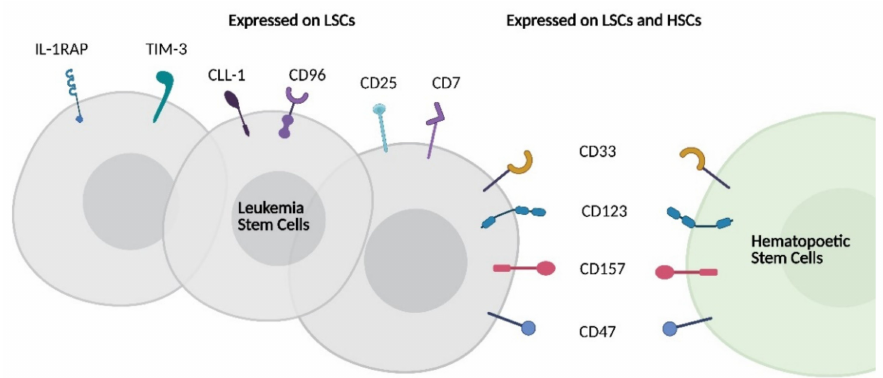
Figure 1. Schematic representing LSC antigen heterogeneity and overlapping expression of thera- peutically relevant LSC antigens with HSCs. LSC = leukemia stem cell; HSC = hematopoietic stem cell; IL-1RAP = IL-1 receptor accessory protein, TIM-3 = T-cell immunoglobulin and mucin-domain containing-3; CLL-1 = C-type lectin-like